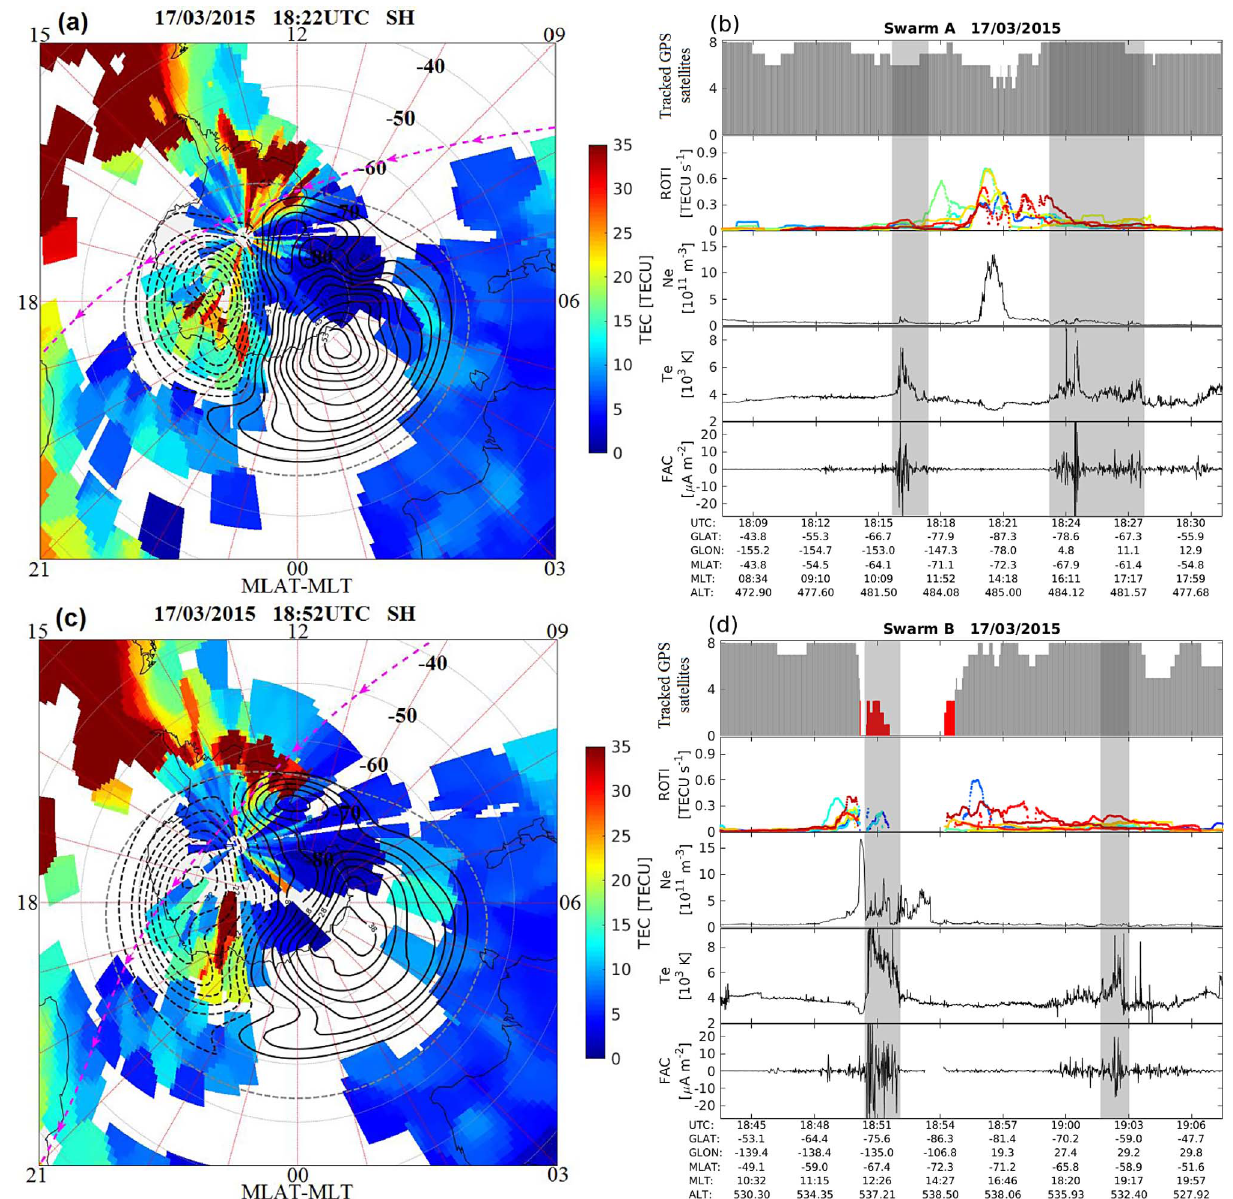
Fig. 3. (a) TEC map as well as the ionospheric convection pattern around 18:22 UTC on 17 March 2015. The orbital track of Swarm A is indicated by the magenta dashed line. (c) In situ measurements from Swarm A from 18:07 to 18:32 UTC, and the panels from top to bottom are the total number of tracked GPS satellites, ROTI, in situ electron density and temperature, as well as the small-scale FACs signatures (<150 km). (c) and (d) are in a similar format as for (a) and (b), but for Swarm B measurements around 18:52